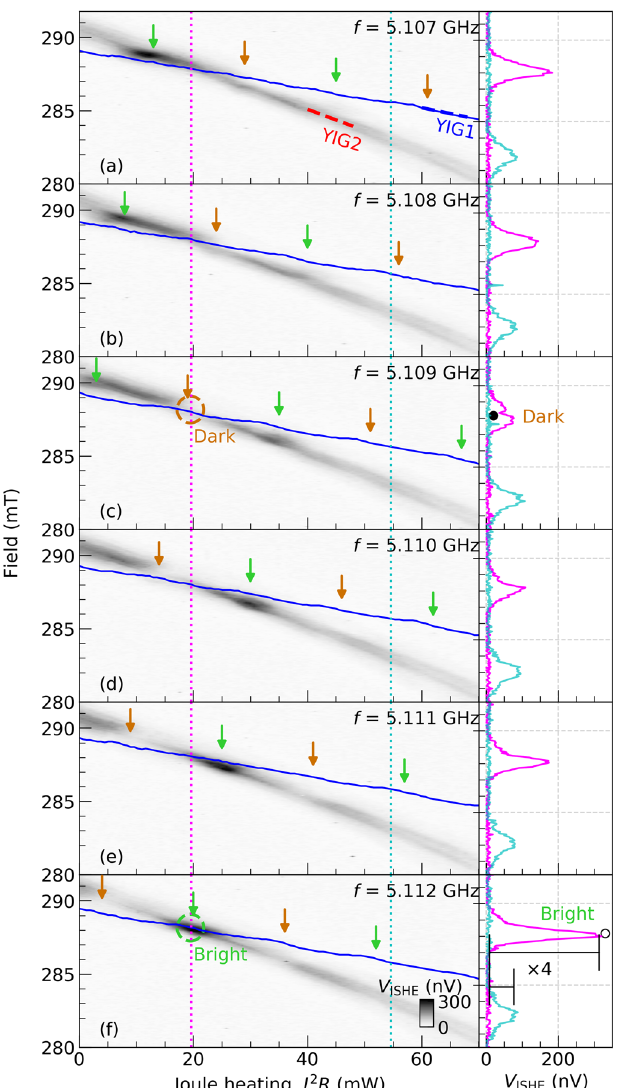
FIG. 3. (a) – (f) Density plots of the spin-pumping-induced voltage V in the Pt contact on the top YIG2 layer as a ISHE function of Joule heating and magnetic field observed at different frequency tuning relative to acoustic resonances (microwave power is set at 0 dBm, and sample orientation is set at θ H ¼ 15 °). The blue solid lines are the maxima of the microwave absorption spectra that are dominated by YIG1. The right compares the modulation of the spin-pumping signal measured either at zero detuning between the two Kittel resonances (purple vertical dotted line) or at large detuning (cyan vertical dotted line). The green and orange arrows indicate the positions of odd and even phonon resonances, respectively, observable as small cusps in the microwave spectra (blue lines). The circles in (c) and (f) emphasize the triple resonance at which all frequencies agree. (c) At the intersection with an even lattice mode, the peak splits and becomes “ dark. ” (f) At the intersection with an odd mode, the intensity gains a factor of 4, which confirms that the magneti- zation amplitudes of both YIG1 and YIG2 interfere construc- tively into a “ bright ”